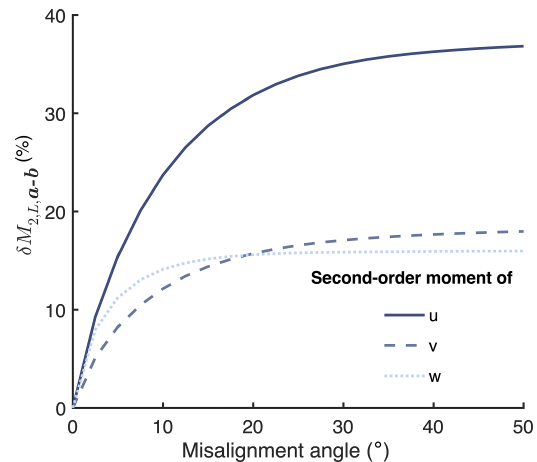
Figure 5. Effect of misalignment angle on normalized spatial vari- ance of the second-order moment of wind speeds u , v and w aver- aged over 10min. The distance between wind turbine and meteoro- logical mast is 200m, as described in Fig.